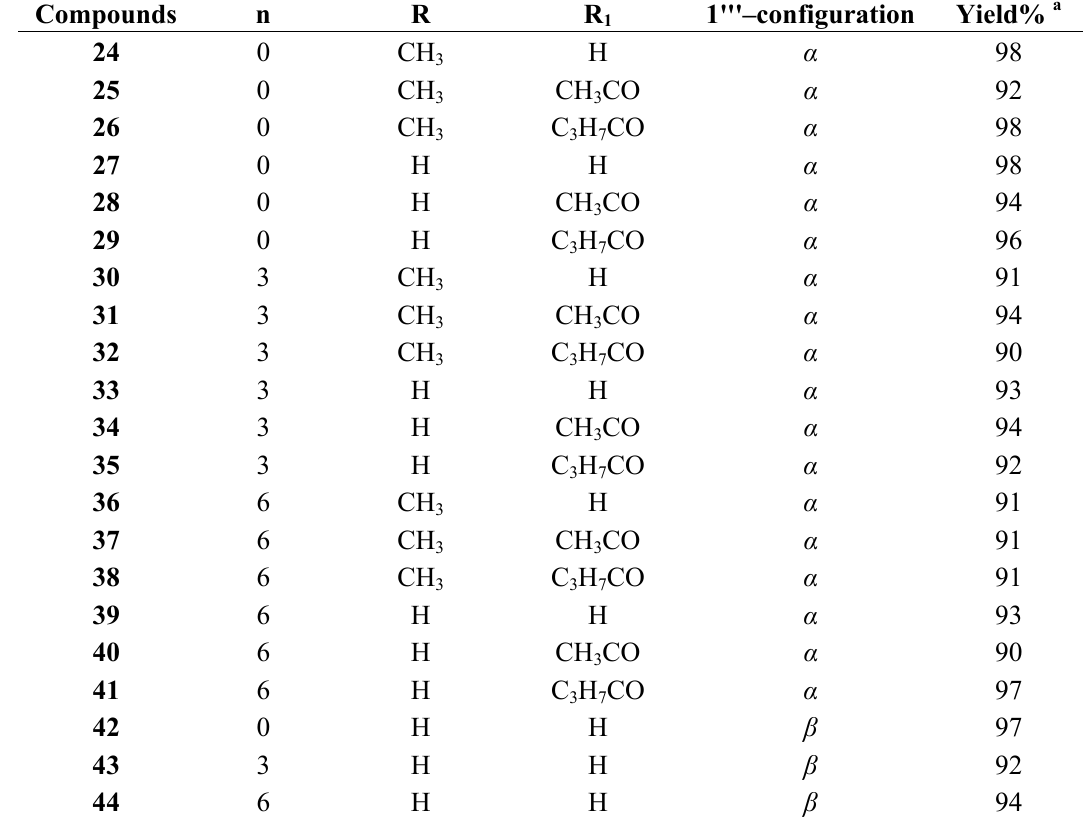
Table 1. A series of 4 β -triazole-linked glucose-podophyllotoxin conjugates.